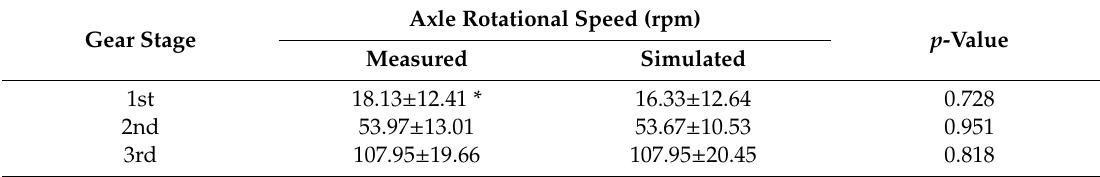
Table 4. Comparison of the axle rotational speed between the measured and simulation results based on the gear stages .